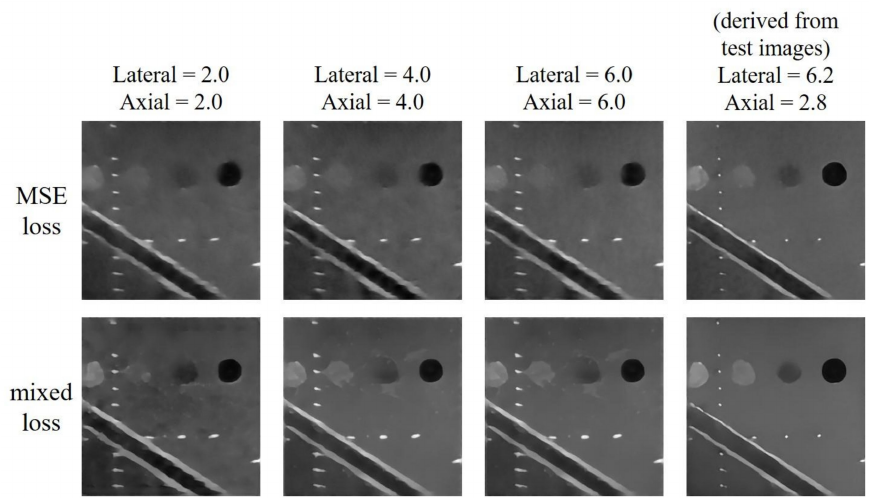
Figure 5. Reconstructed echogenicity maps of the two training options using training dataset of di ff erent size of point spread function